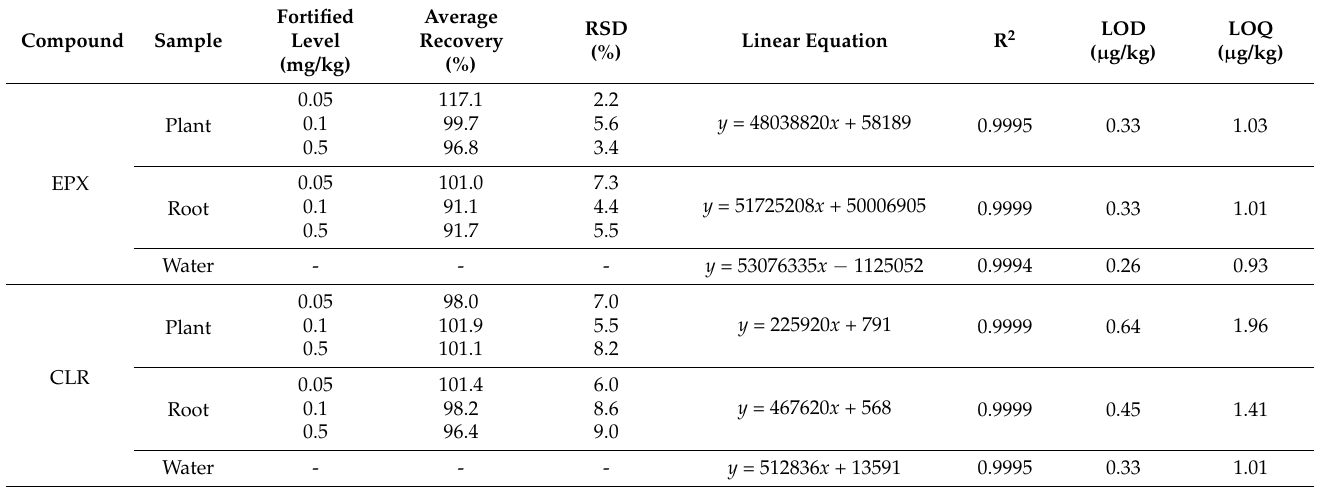
Table 4. Recoveries, RSDs, linear equation, coefficients of determination (R2), LODs, and LOQs of EPX and CLR in different